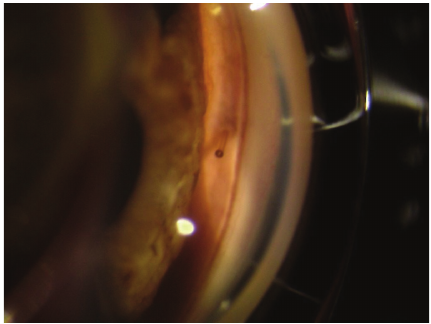
Figure 2: 15 days after surgery, the stent was exposed in its terminal